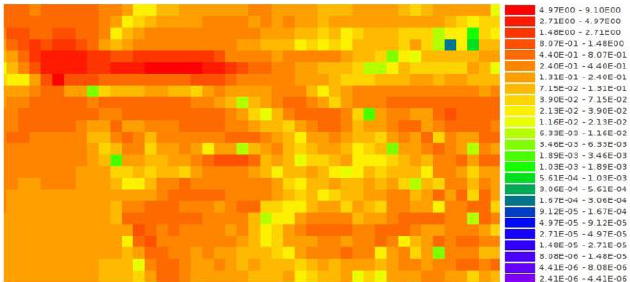
Fig. 6. Relative change of total neutron flux (MCNP as